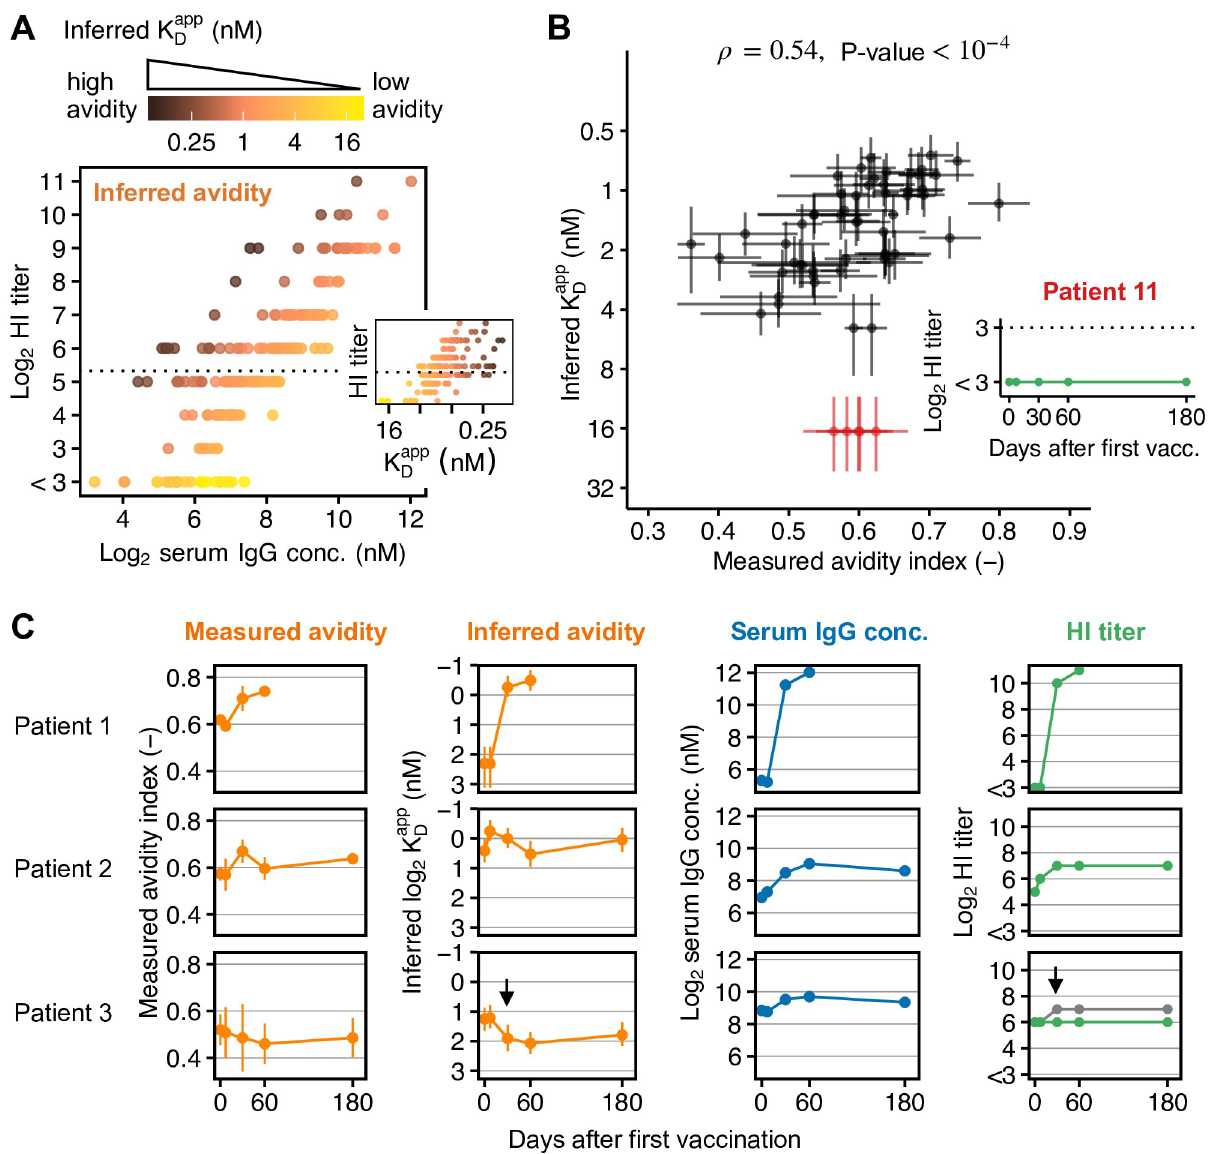
Fig 3. Inference of antibody avidities in HSCT patients. ( A ) ELISA-detected anti-H1N1pmd09 serum IgG concentration, HI titers and corresponding inferred apparent dissociation constants K app from 197 serum samples from 43 HSCT patients. The dashed line indicates the D seroprotection threshold (HI titer � 40). ( B ) Correlation of inferred and experimentally determined avidities in 59 serum samples from 12 HSCT patients (Pearson’s ρ = 0.54, 95% CI = [0.31, 0.70]). Data show mean and standard deviation for avidity indices from two experiments (each performed in duplicates) and the median of the posterior distribution with the uncertainty range due to discretized HI titer measurements and ELISA measurement error for inferred K app -values (see Methods for details on inference and S2 Fig for posterior distributions). Avidity indices correspond to D the fraction of H1N1pmd09-specific serum IgG remaining bound after 4M urea treatment. Patient 11 was identified as an outlier, probably because ELISA detected non-neutralizing IgG; the patient showed no HI activity at any time point. For serum samples without detected HI activity (HI titer < 8; all five samples from patient 11 and three additional samples from in total two patients), the measured avidity index is plotted against the estimated upper bound for the inferred avidity and the uncertainty interval reflects the estimated uncertainty of the upper bound due to discretized HI titer measurements and ELISA measurement error. ( C ) Example patients with different types of responses to vaccination. In patient 3, we detected an increase in non-neutralizing IgG on d30. The predicted HI titer for the observed increase in IgG (shown in gray) is twice as high as the actually observed titer (green). For all 12 patients with experimentally determined avidities see S3 Fig.